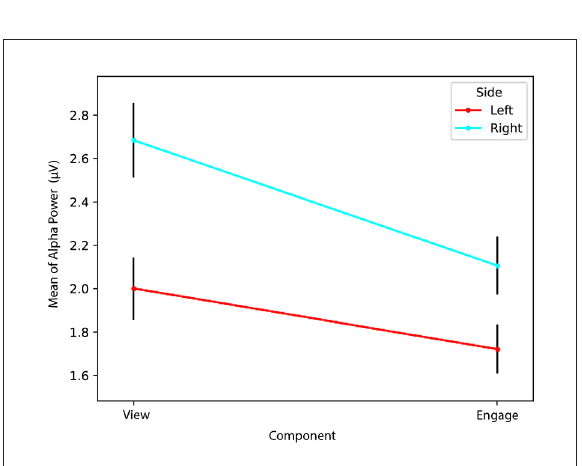
FIGURE11 Successful Blocks. Both Right and Left alpha power decrease from View to Engage , but Right remains significantly greater than Left during Engage